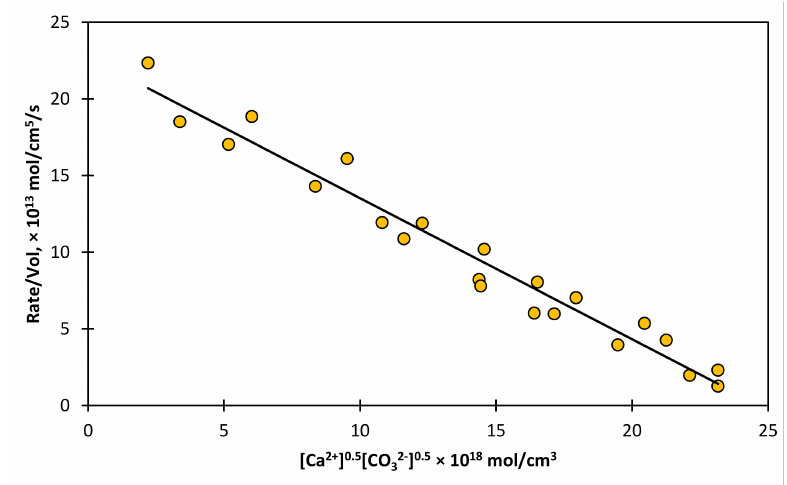
Figure 7. The rate (per unit volume) of the reverse reaction for the dissolution calcite at 21 ◦ C in a solution of 0.7 M KC1 at pH values between 8.0 and 10.1, showing that the rate of the reverse reaction is proportional to [Ca 2+ ] 1/2 [CO 3 2 − ] 1/2 . The line represents the surface-vacancy model. Data from Sjöberg [71]. See also Crundwell